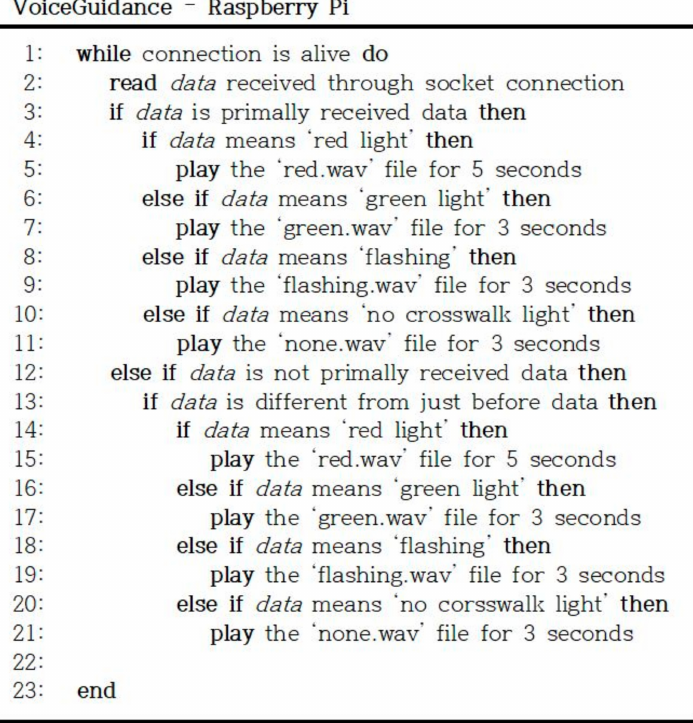
Figure 5. Algorithm for voice guidance determination of Raspberry